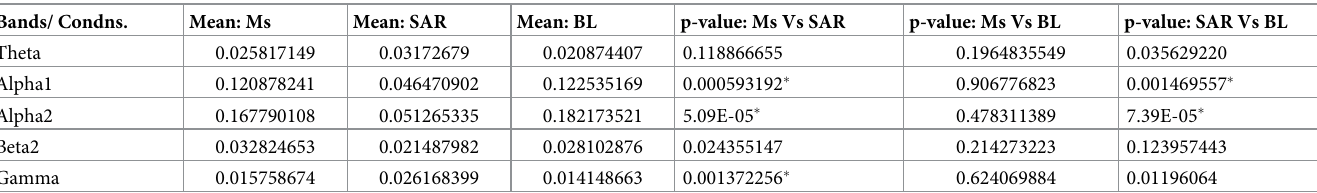
Table 1. Mean phase coherence analysis. Bands/